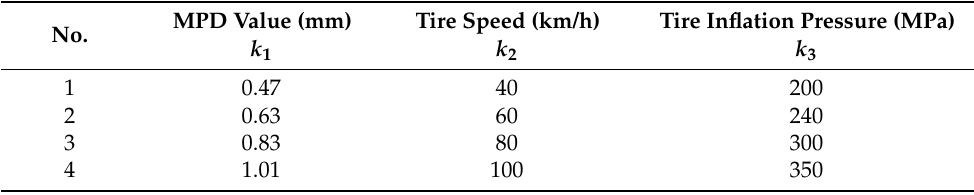
Table 3. Levels of influence factors in a dry road state.